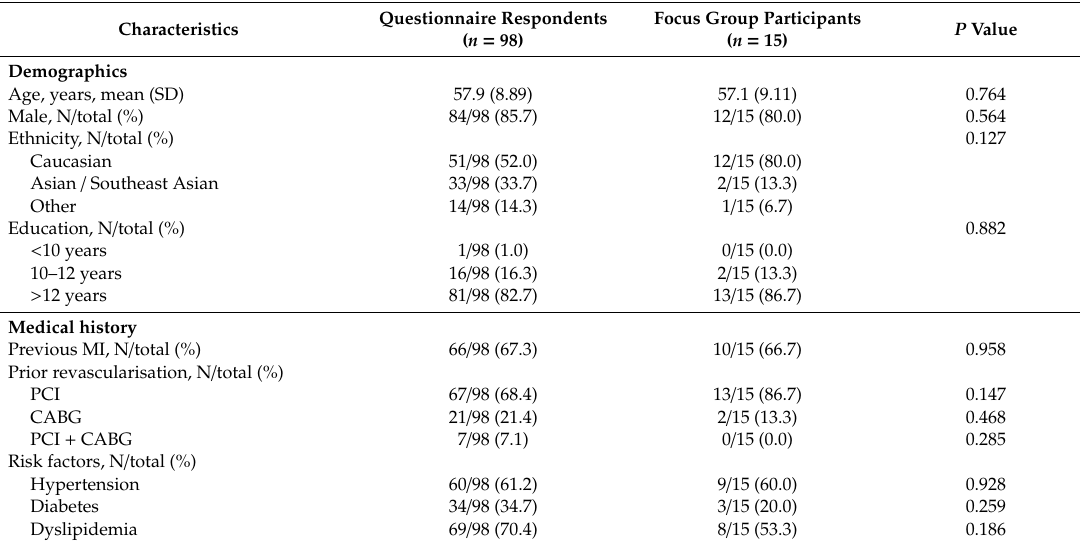
Table 4. Questionnaire respondents and focus group participants’ characteristics.